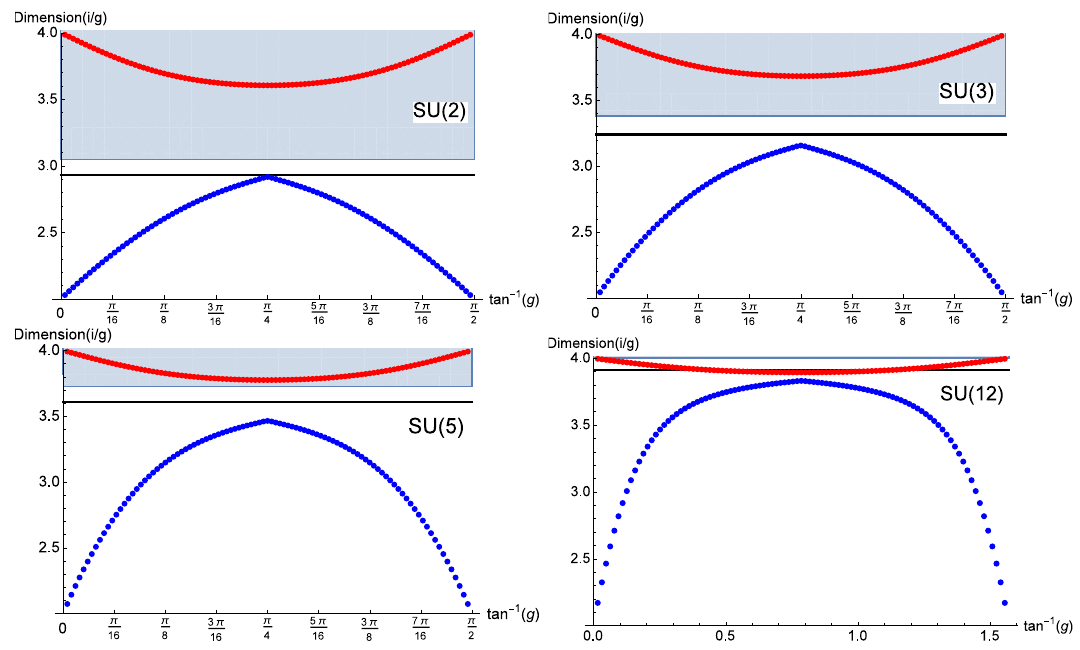
Figure 15 . Comparison of the dimensions of the leading and subleading twist operators with spin- 0 as functions of g for (cid:18) = 0 and various N . The red line indicates the subleading interpolating function and the blue line represents the leading interpolating function. The shaded region and horizontal black solid line are the upper bounds and corner values for the leading twist operator obtained by the N = 4 superconformal bootstrap, respectively.